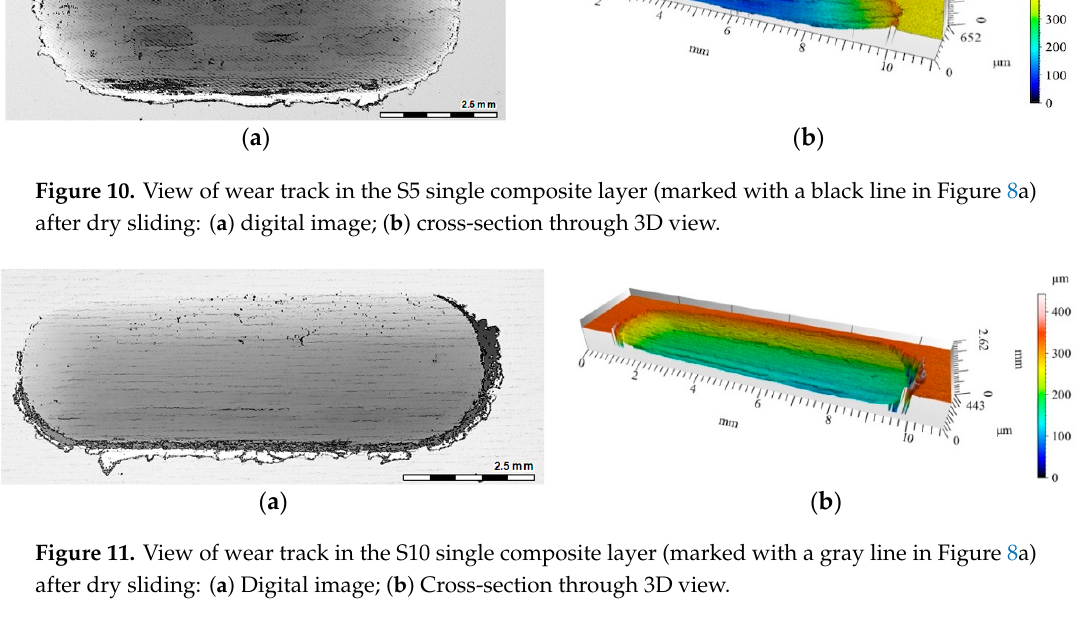
p and GC sf ) materials stabilized a significantly reduced the